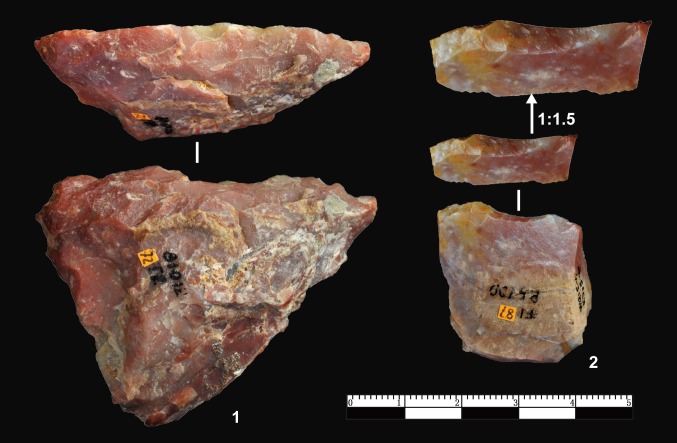
Profiles of finely retouched pieces from DGT.No. 1: Repeated retouch along a single working edge (the retouch is inversely applied up to 15 mm).; No. 2: Very fine and regular retouch along a single working edge. The retouched working end is smooth and sharp.